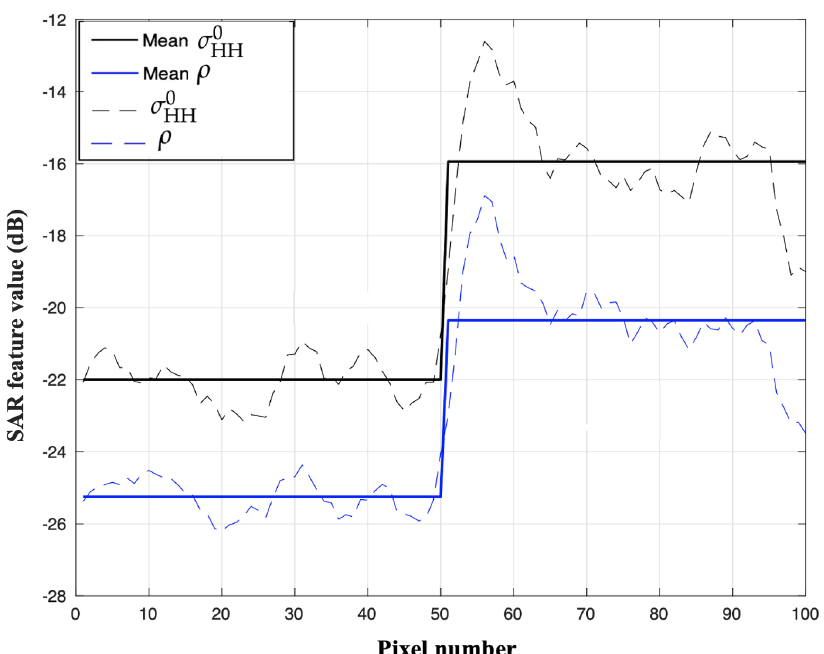
Figure 6. Frozen case. Dashed lines refer to σ 0 (black) and ρ (blue) values evaluated as an average HH over the four transects shown with red dashed lines in Figure 3a,d. For reference purposes, the σ 0 (black) and ρ (blue) mean values estimated for the sea and glacier ROIs (see Table 2 and Figure 3a,d) are depicted as continuous